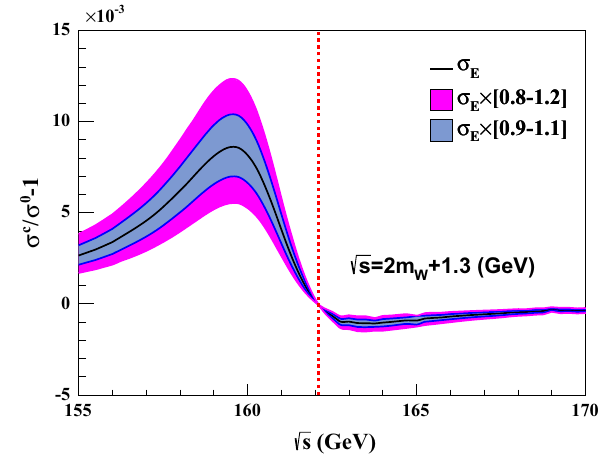
Fig. 7 The distribution of the ratio between the cross sections with different σ E and the one without the energy spread. The central curve correspondstothepredictionobtainedwith σ E = 0 . 1%(relativevalue), which is the design value of the CEPC. Purple and blue bands show the ratio curves obtained varying the nominal σ E with [0.8, 1.2] σ